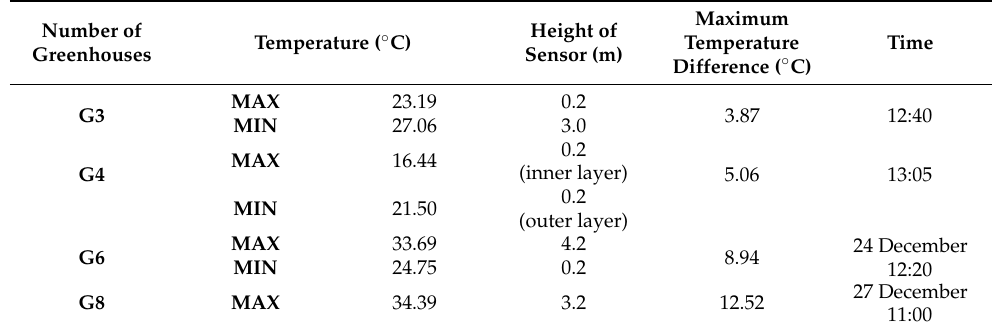
Table 5. The maximum temperature difference (between max and min of sensor reading) in each greenhouse at the same